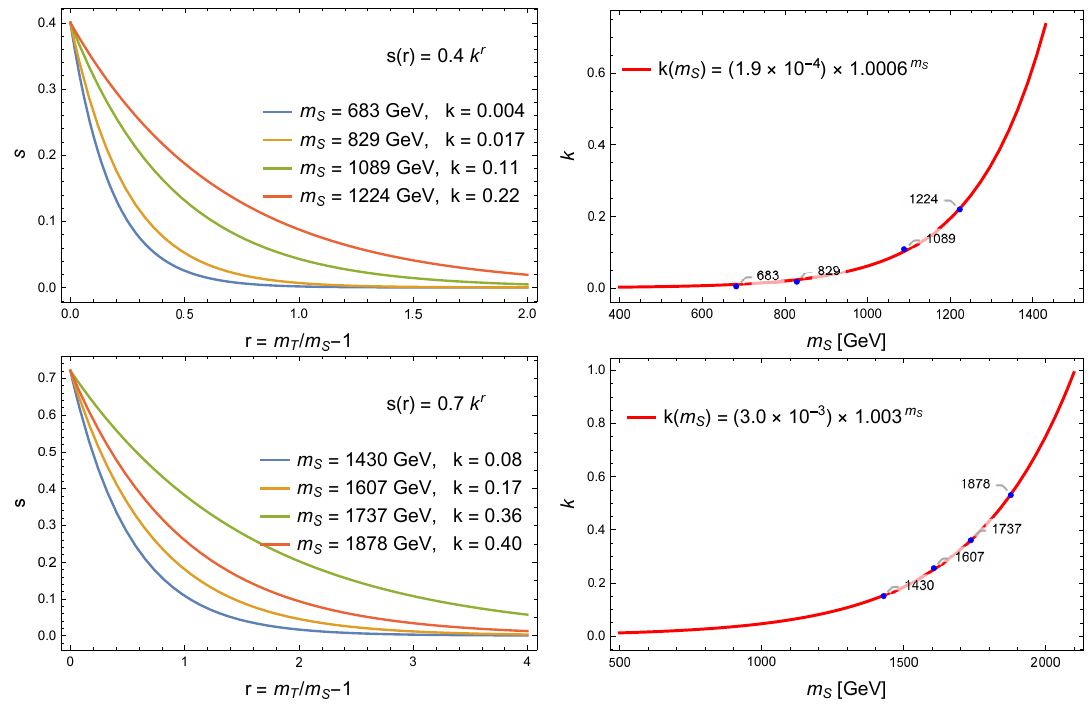
Figure 12 . Left figures — Deviation function (A.3) for several m S benchmark points. it parametrises the deviations between the fit function (2.11) and our predictions in the compressed regime, and it is shown as a function of r . Right figures — Value of the k parameter driving the deviations from the fit across the considered mass points. This exhibits again an exponential struc-